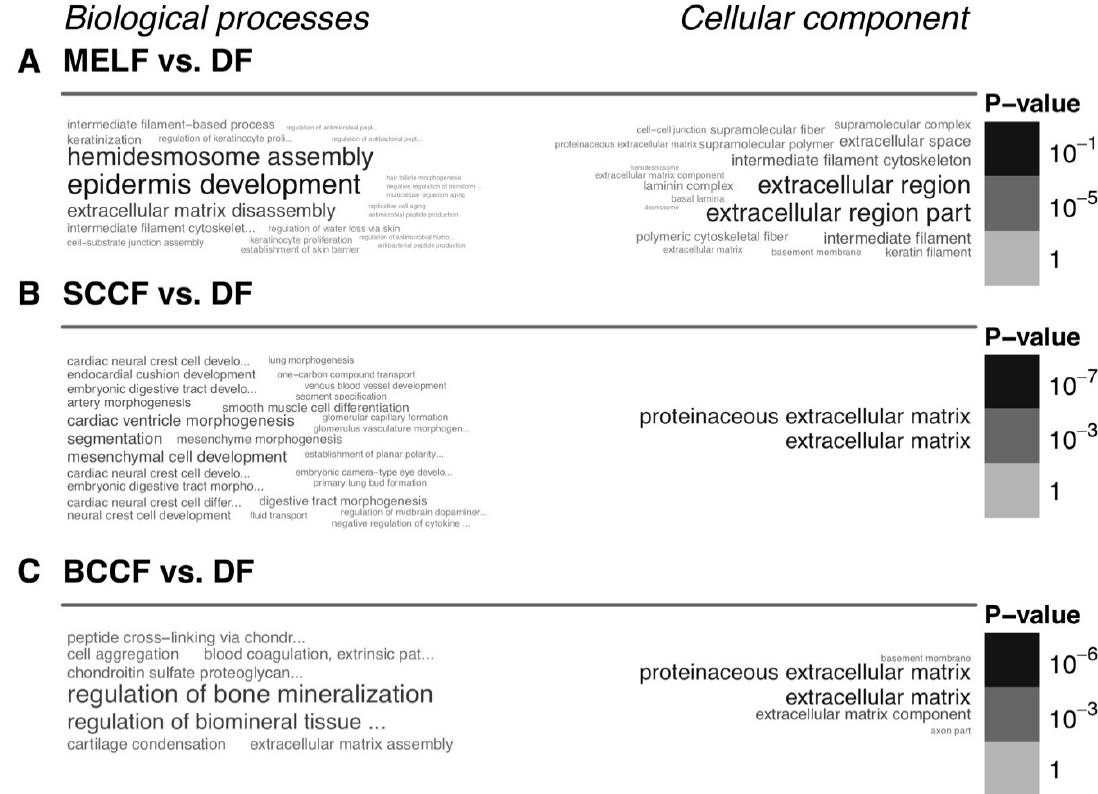
and elderly patients were also observed